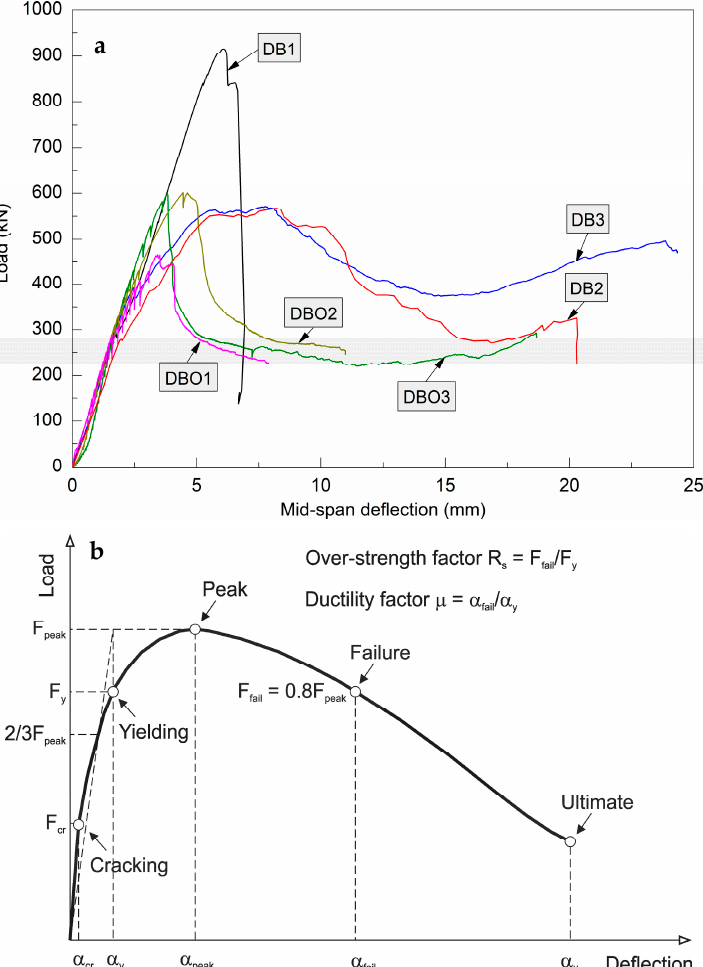
Figure 8. DB and DBO ( a ) load-deflection curves; ( b ) definition of cracking point, yielding point, failure point, over-strength factor and ductility factor. Table 4. Load-deflection response results of deep beams at cracking, yielding, peak and failure loads.